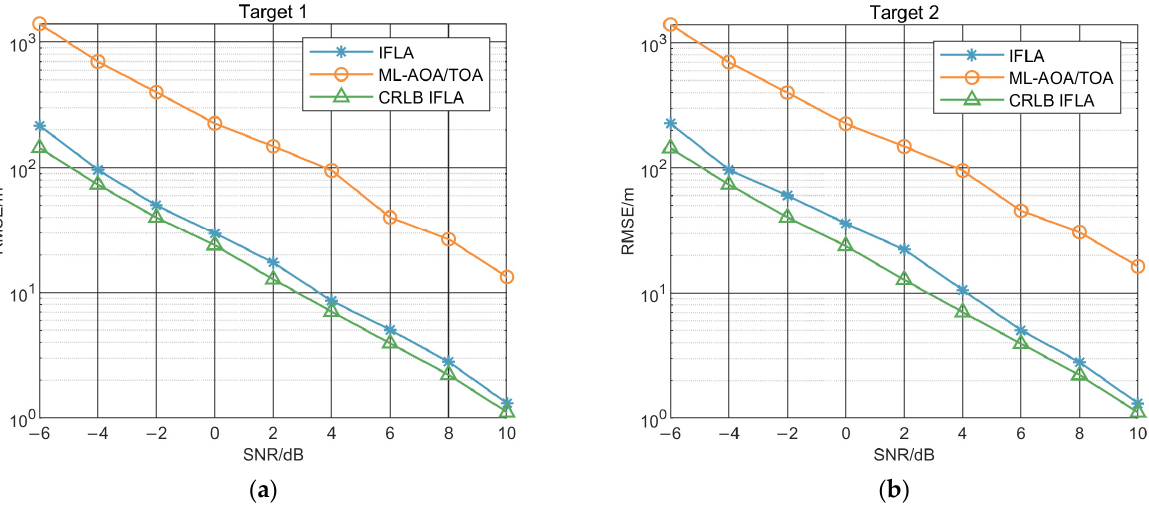
Figure 6. Estimation accuracy comparison of IFLA (blue) and ML_AOA (orange)/TOA (green) for target 1 ( a ) and target 2 ( b ).